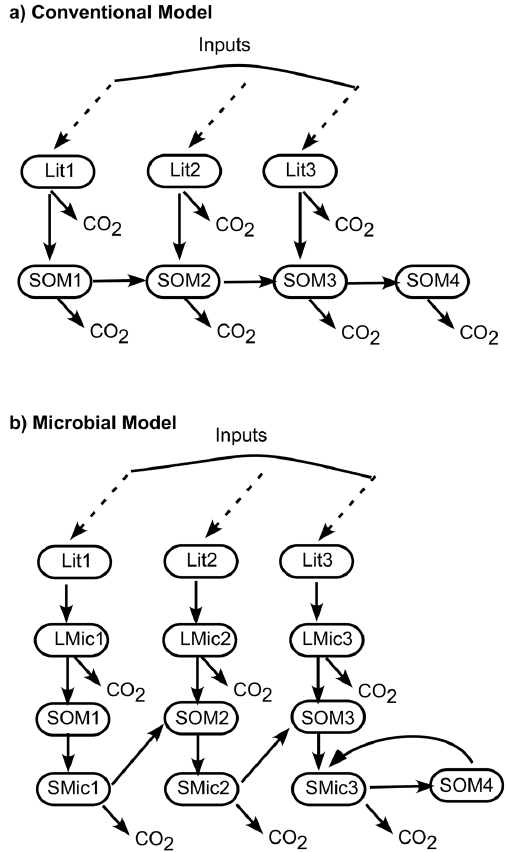
Fig. 1. Diagram of soil C models. (a) Conventional model and (b) microbial model. Lit, SOM, and Mic stand for C pools for litter, soil organic, and microbial biomass, respectively. Dashed arrows are plant inputs. Solid arrows are fluxes between